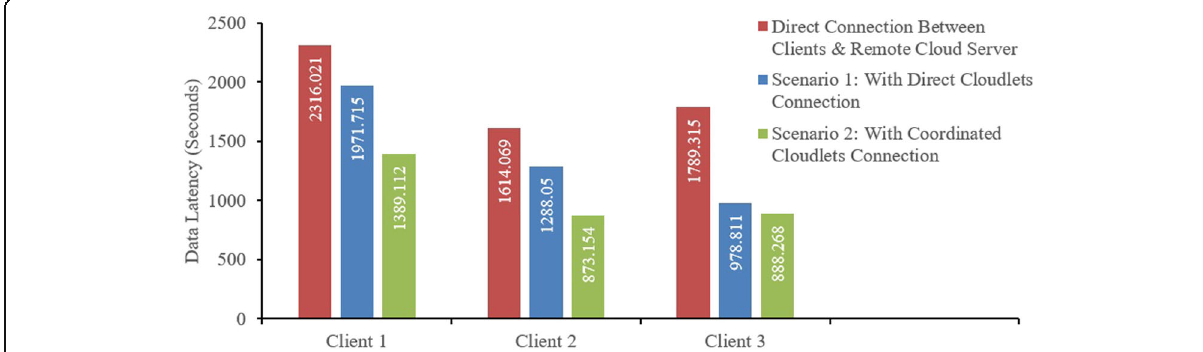
Fig. 10 Performance Comparison with Direct Connection, Scenario 1, and Scenario 2